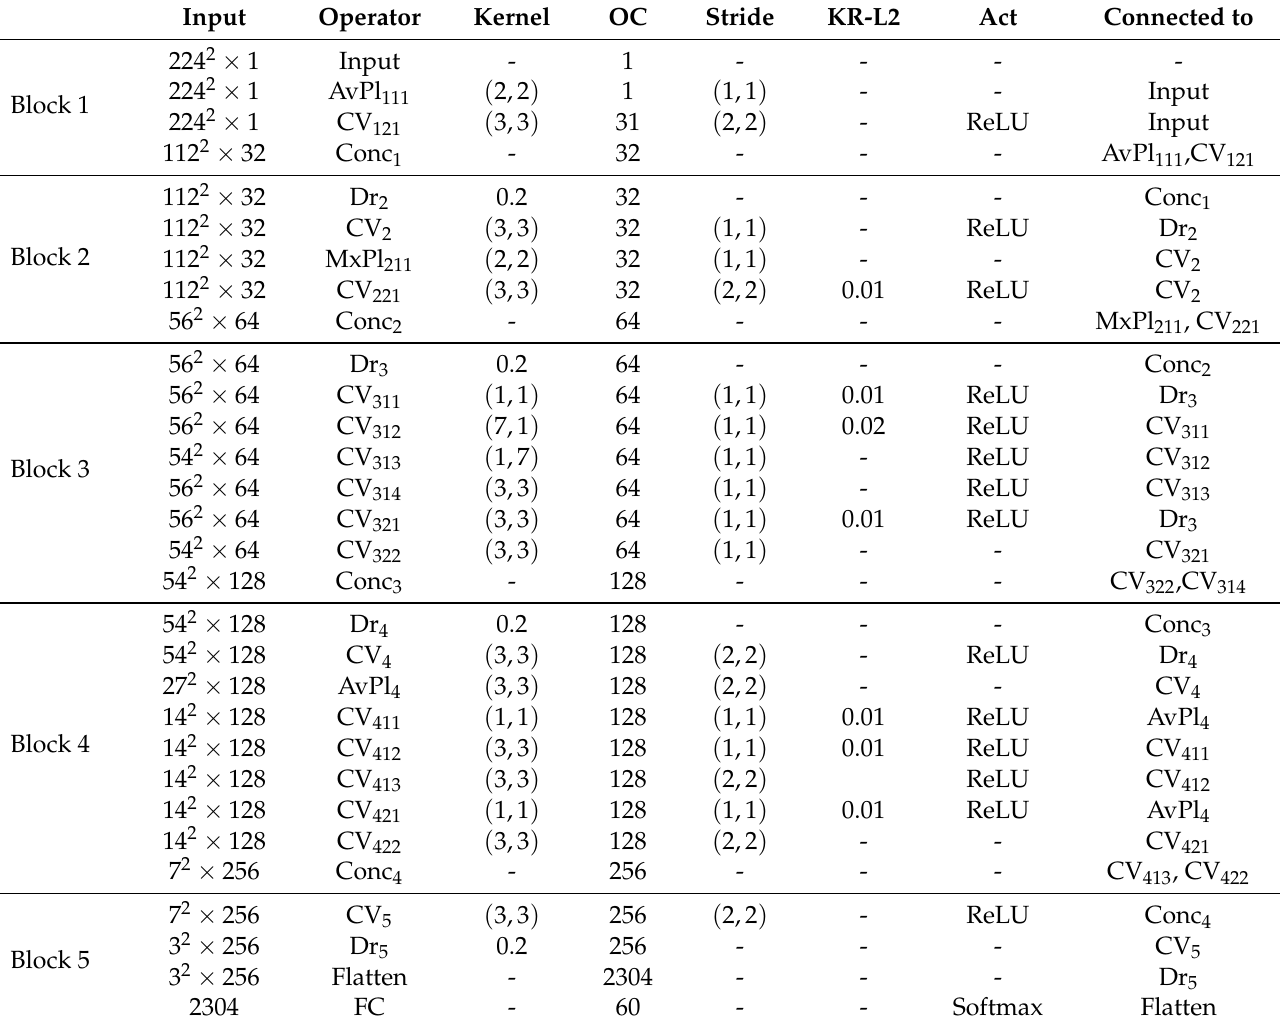
Table A1. Each line represents a layer of the model graphically represented in Figure 5. From left to right we have represented by columns the input dimensions, the type of layer, the kernel size, the output channels, the stride length of the convolution and pool layers, the L2 kernel regularizer, the activation function and the connections with previous layers. The following list of abbreviations for layer names has been applied: Convolution2D (CV), Average Pool (AvPl), Max Pool (MxPl), Dropout (Dr), Concatenate